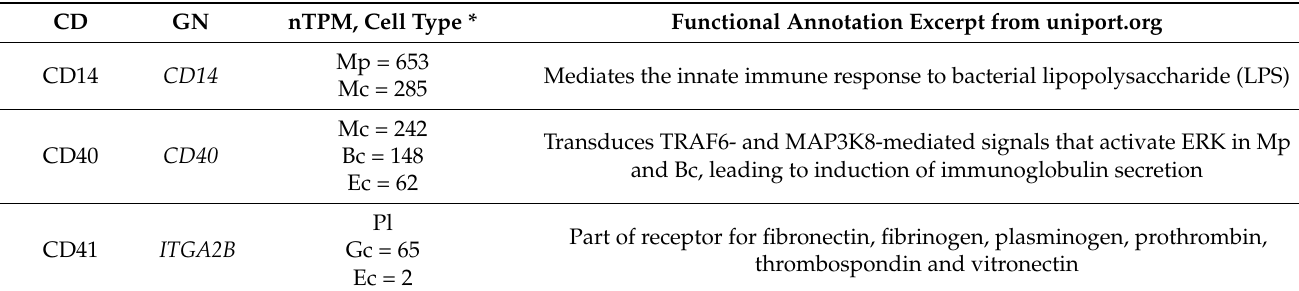
Table 2. cEV-associated cell-type specific proteins that were used to assess cell-type specific damage by way of